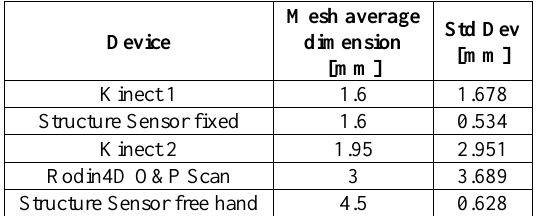
Table 6. Values of mesh size and standard deviation of